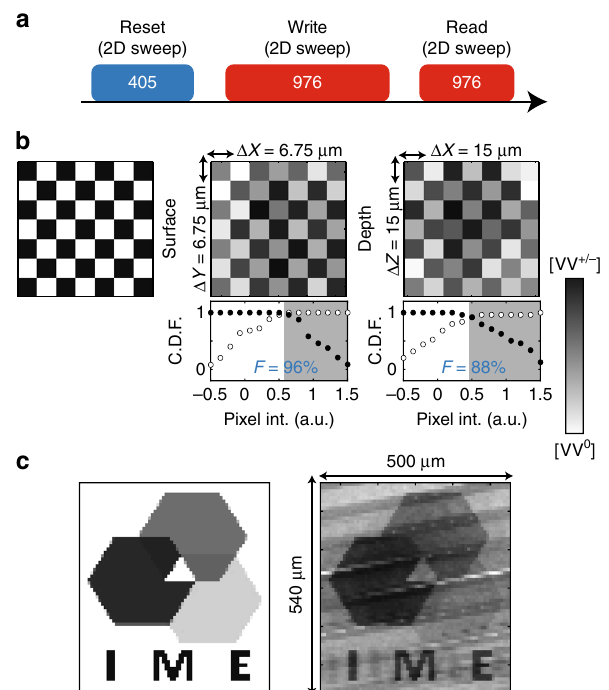
Fig. 7 Spatial and amplitude control of the divacancy charge conversion. a Imaging sequence for b , c , with three sequential 2D sweeps: (1) Reset to high VV 0 concentration using 405 nm. (2) Write using 976 nm with varying duration for charge conversion back to a desired lower VV 0 concentration. (3) Read with a fast 976 nm pulse. b Pixel test of spatial control with, from left to right, the original pattern, the measured pattern in the X − Y plane (parallel to the sample surface) and the measured pattern in the X − Z plane (orthogonal to the sample surface). For X − Z , the intensity is normalized to the PL collection ef fi ciency across the sample depth. Below each image, the corresponding cumulative distribution function (C.D.F.) is plotted from cumulative binning of the pixels according to their intensity (int.) and expected color (black/white dots for black/white pixels). The fi delity F is de fi ned as 1 (cid:1) P b w jð Þ (cid:1) P w b jð Þ ; where P i j jð Þ is the probability of measuring i expecting j , where i , j = black (b), white (w), and the expected color is given by the background color in the plot 50 . c Amplitude control of the charge conversion using a gray scale image (left: original image, right: